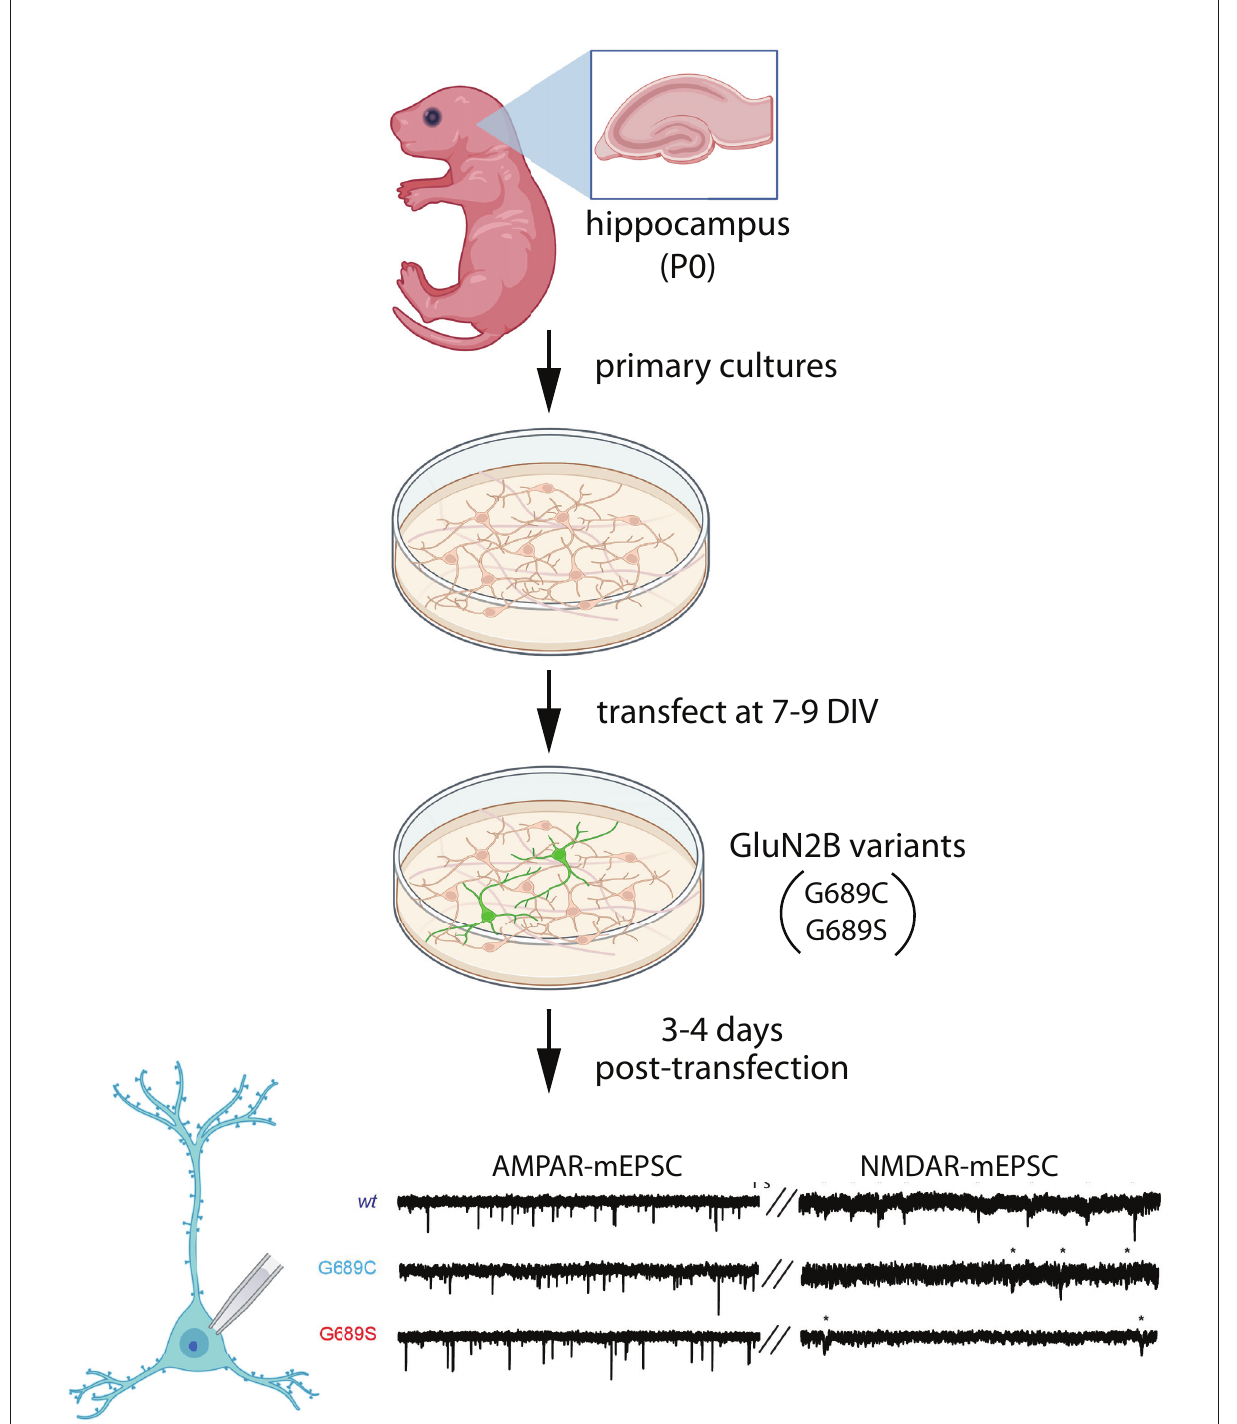
FIGURE4 Expression of GluN2B variants does not affect synapse number but reduces NMDARs at synapses. Primary neuronal cultures were generated from P0 rat hippocampus, then transfected at 7–9 DIV with disease-associated GluN2B variants, G689C or G689S, in the LBD (Kellner et al., 2021). After 3–4 days, miniature excitatory postsynaptic currents (mEPSCs) were subjected to patch clamp recording, separating NMDAR- and AMPAR- mediated components of mEPSCs. AMPAR-mEPSC frequency was unchanged, suggesting no change in the number of synapses. However, the frequency of NMDAR-mEPSCs was reduced, likely due to an increase in synapses that lack NMDARs. Illustrations were partially created with BioRender.com. Recordings are from Kellner et al.